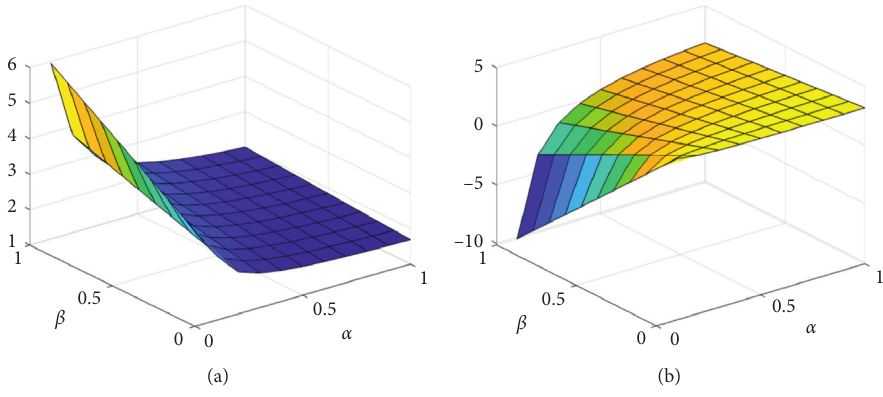
Figure 9: Price strategies under the Stackelberg game. (a) p L (b) p F